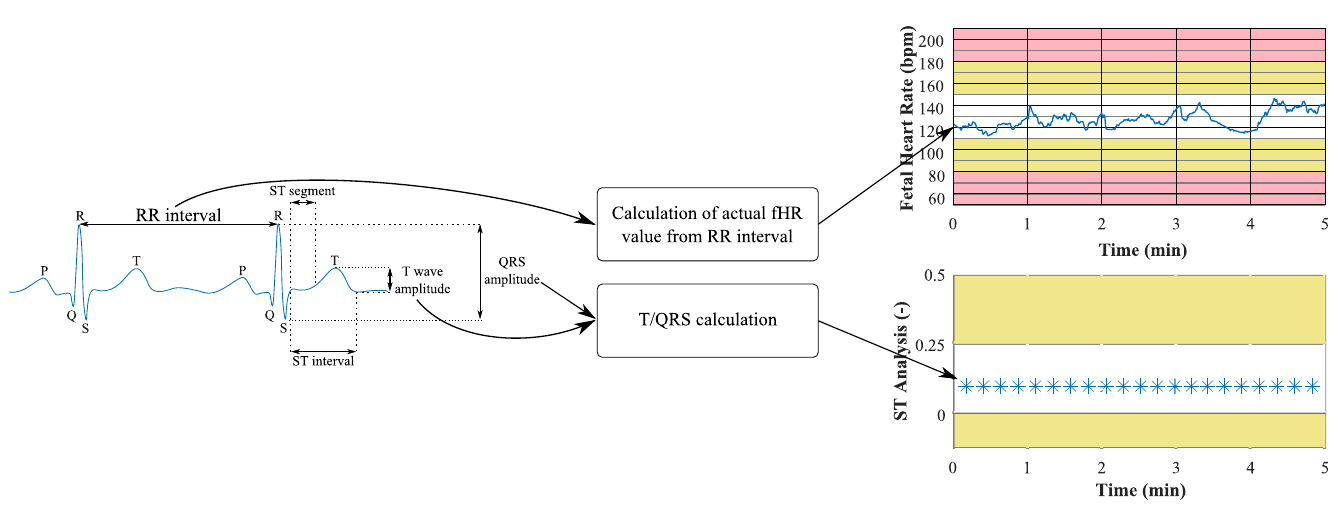
Fig 1. Principle of fHR calculation and determination of ST analysis inspired by STAN